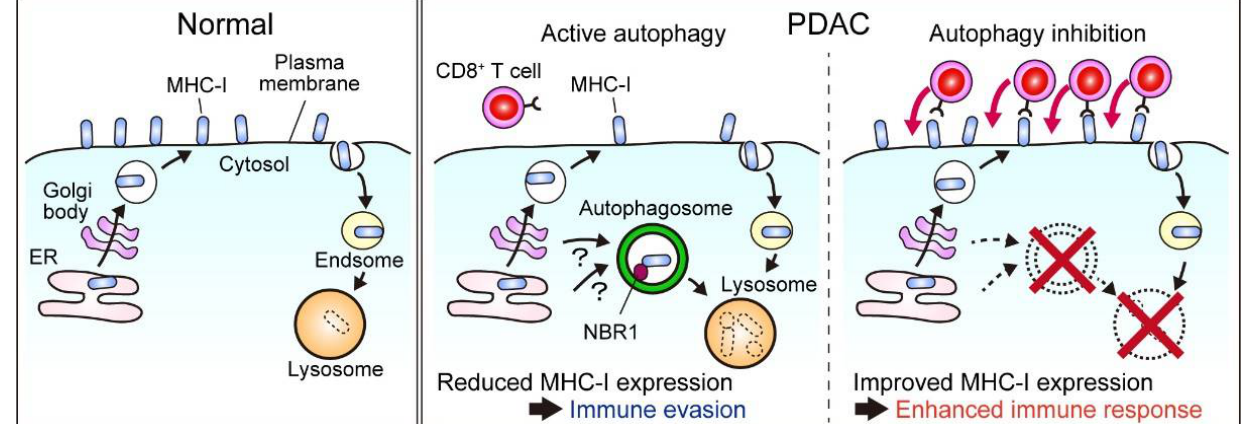
Figure 5. Autophagy facilitates immune evasion of PDAC via the selective removal of the major histocompatibility complex class I (MHC-I) [136,137]. In PDAC cells, MHC-I is degraded via NBR1- mediated selective autophagy, thus reducing the cell surface MHC-I expression and promoting the immune evasion of PDAC cells. Blocking autophagy or lysosome restores the cell surface MHC-I levels in PDAC cells and improves CD8 + T cell-mediated PDAC cell recognition and killing, triggering a robust anti-tumor immune response that can be further augmented via combined treatment with immune checkpoint blockade (ICB) agents. Figure 5 is adapted from reference [41], the use of which is licensed under a Creative Commons Attribution 4.0 International license https://creativecommons.org/licenses/by/4.0/.